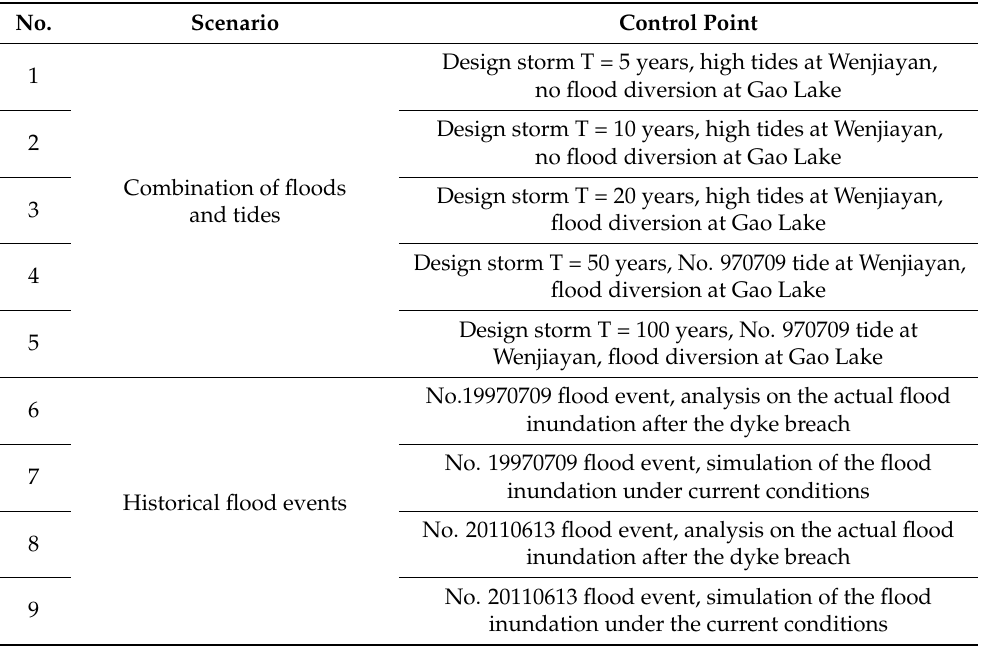
Figure 5. Hydrographs of the historical flood No. 20110613 at Zhuji ( above ) and Meichi ( below ) hydrological stations. Table 7. Flood scenario description of the Puyang River